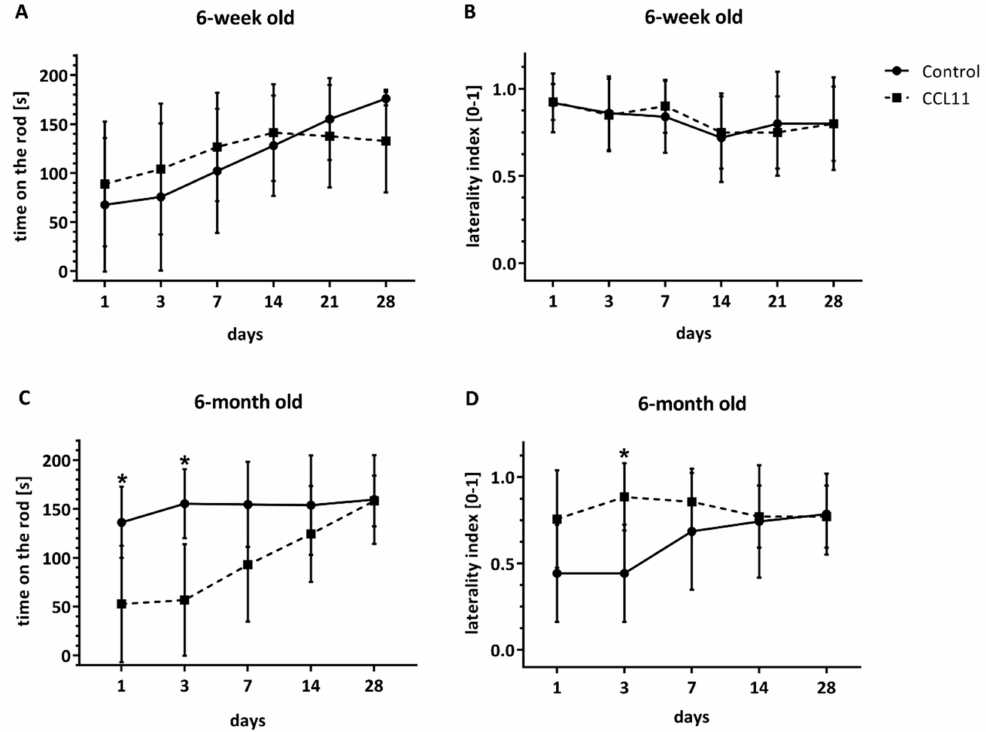
Figure 2. CCL11 impairs post-stroke neurological recovery in adult mice. C57BL6 male mice were subjected to cerebral ischemia for 45 min followed by reperfusion for 28 d. At the beginning of the reperfusion, mice received intraperitoneal injections of either 10 µ g / kg bodyweight of CCL11 or 100 µ L of PBS as control followed by daily injections on the seven consecutive days after reperfusion. At the time points given, behavioral tests were performed. For assessment of motor coordination deficits, the rota rod test in ( A ) of adolescent mice (ns p = 0.965 at day 1, ns p = 0.872 at day 3, ns p = 0.933 at day 7, ns p = 0.997 at day 14, ns p = 0.987 at day 21 and ns p = 0.496 at day 28) in ( C ) of adult animals (*significantly di ff erent from the corresponding control, p = 0.008 at day 1, *significantly di ff erent from the corresponding control p = 0.001 at day 3, ns p = 0.085 at day 7, ns p = 0.997 at day 14, p = 0.758 and ns p = 0.999 at day 28) and the corner turn test in ( B ) of adolescent mice (ns p = 0.999 at day 1, ns p = 0.999 at day 3, ns p = 0.993 at day 7, ns p = 0.999 at day 14, ns p = 0.997 at day 21 and ns p =